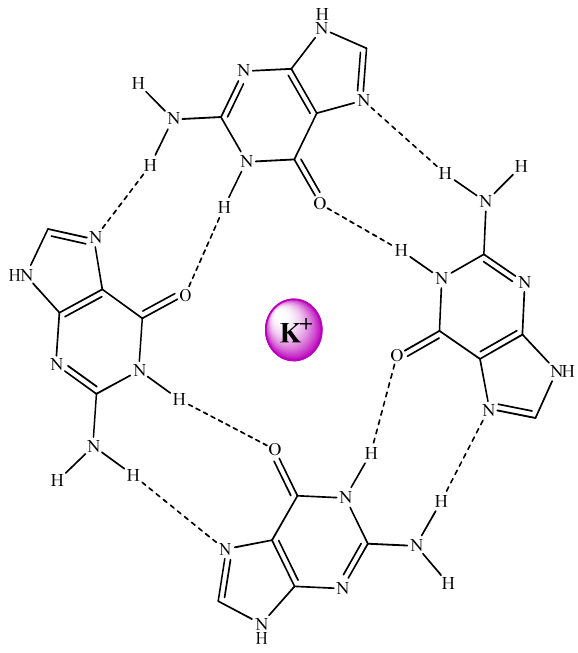
Figure 26. G-tetrad structure including an alkali cation in the center.